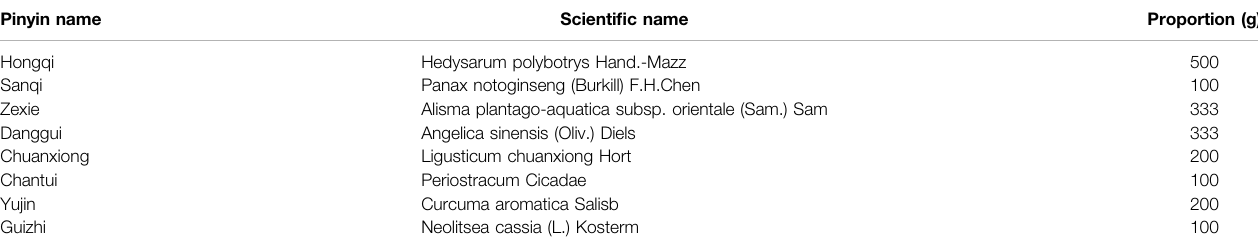
TABLE 2 | Standard formulation of BuqiTongluo